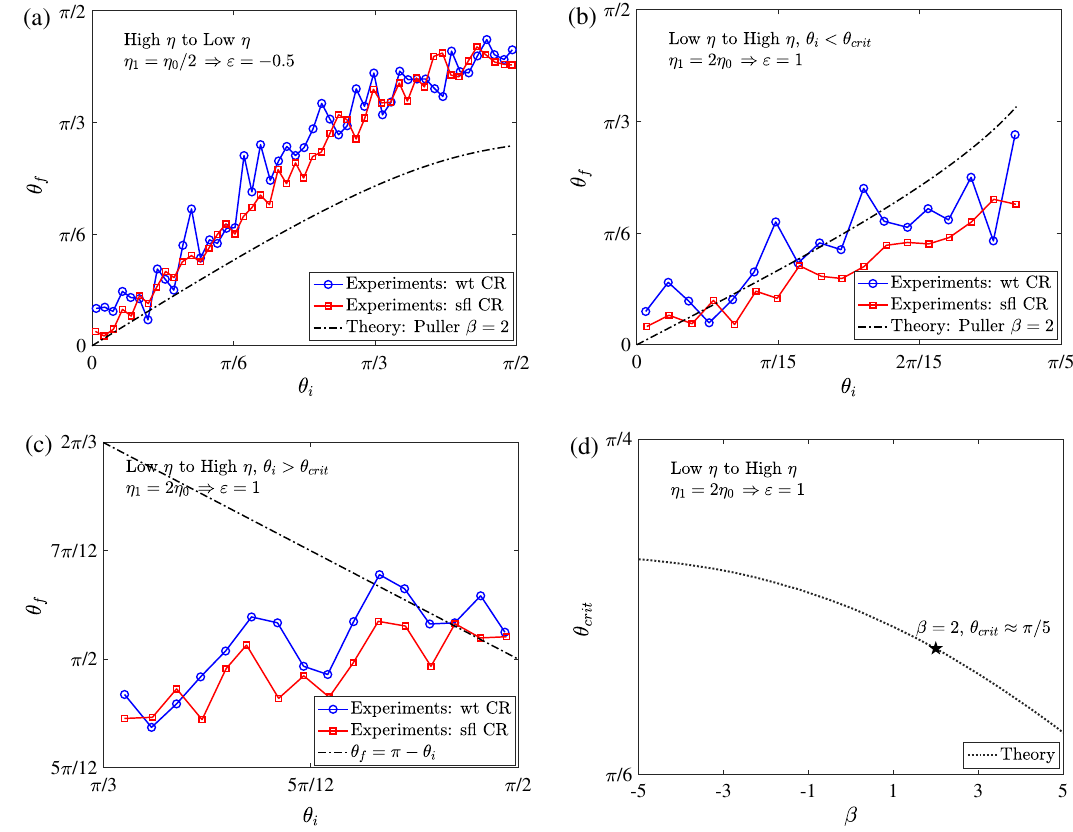
Figure 5. The reorientation of active particles that cross the interface ( a ), ( b ), are reflected by the interface ( c ), and the critical orientation required for scattering from the interface ( d ). Here, the lines with symbols in ( a ), ( b ), and ( c ) represent the previous experiments using wild-type (wt) or short-flagellated (sfl) Chlamydomonas Reinhardtii 25 while the dash-dotted lines correspond to the current theory for pullers β = 2 . Also, the only line in ( d ) represents the current